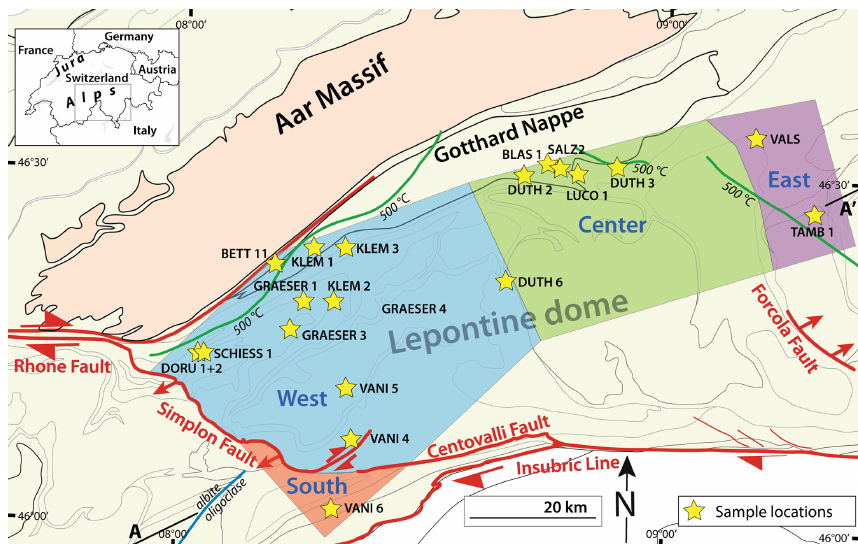
Figure 1. Map of the Lepontine Dome, modified from Steck et al. (2013) and Schmid et al. (2004). Colored areas mark the areal division in the context of this study. The 500 ◦ C isograd was taken from Todd and Engi (1997) and Wiederkehr et al. (2008), and the albite–oligoclase mineral zone boundary was taken from Beard (1958). Section A–A (cid:48) is shown in Fig.